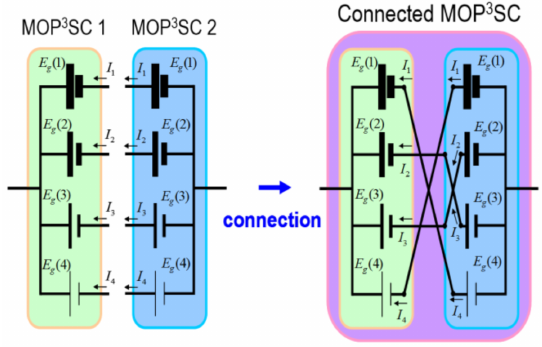
Figure 14. Connected MOP 3 SC (Reproduced from [38], the union of ecodesigners, 2009).